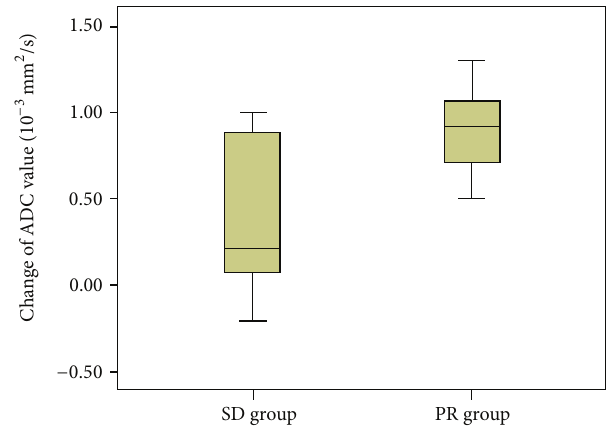
Figure 3: The box plot showed that the change of apparent diffusion coefficient (ADC) value in partial response (PR) group were statis- tically significantly greater than that in stable disease (SD) group.